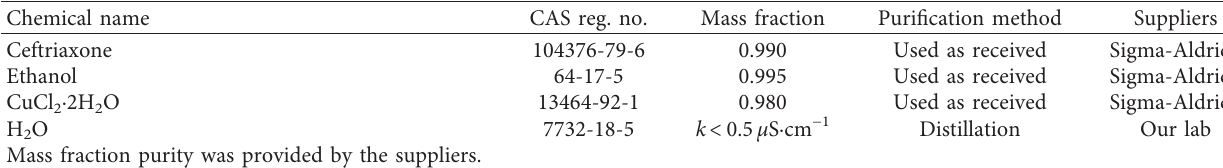
Table 1: Sources and purity of the materials.